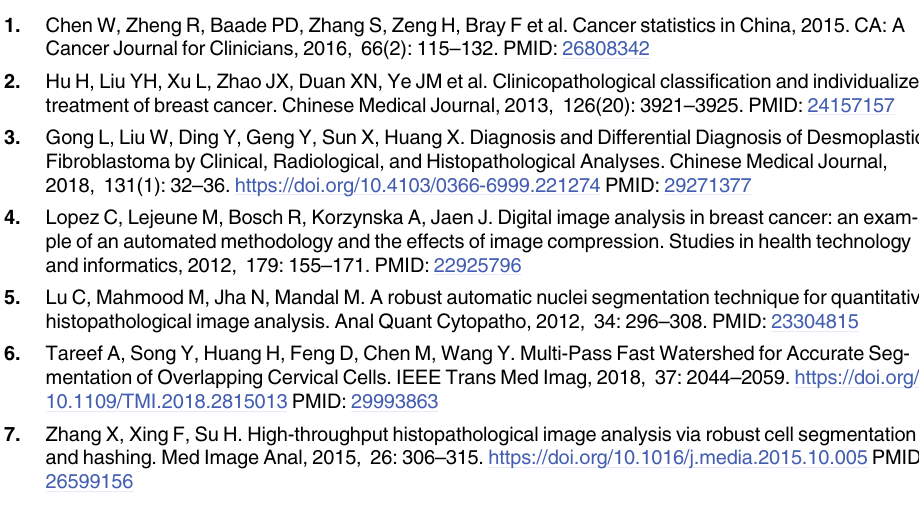
S2 Fig. Original pathological images of Fig 5 in the main body. (ZIP) S3 Fig. Original pathological images of Fig 6 in the main body. (ZIP) S4 Fig. Original pathological images of Fig 8 in the main body. (ZIP) S5 Fig. Part 1 of original pathological images of Fig 7 in the main body. (ZIP) S6 Fig. Part 2 of original pathological images of Fig 7 in the main body. (ZIP) S1